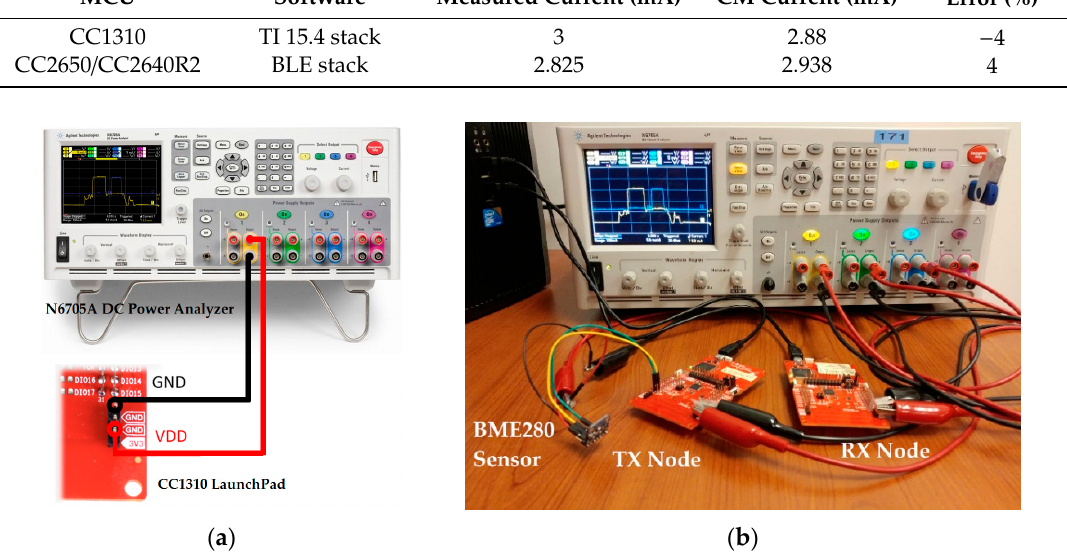
Figure 2. ( a ) Clear cable connections of the ( b ) current consumption measurement setup of the CC1310 wireless MCU while performing a point-to-point communication of an internal temperature sensor data and running the TI 15.4 network stack.